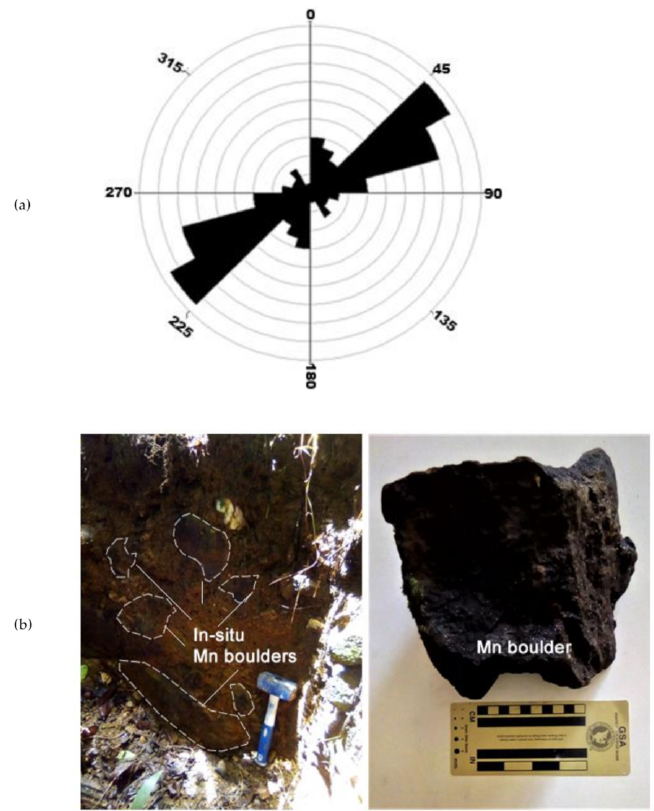
Figure 7. ( a ) The rosette of fracture directions in the study area from geological mapping. ( b ) A section of an abandoned mining pit dug to excavate Mn deposit in Oban area (NB. Mn boulder is enlarged for clarity).